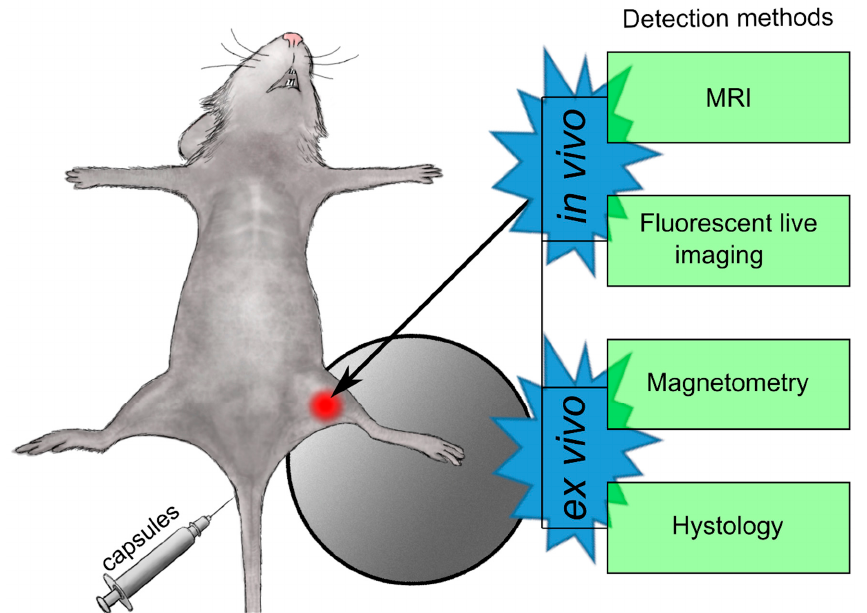
Figure 2. Schematic illustration of in vivo administration of the carriers and subsequent analysis using combined imaging instruments, magnetometry, and histology to elucidate carrier